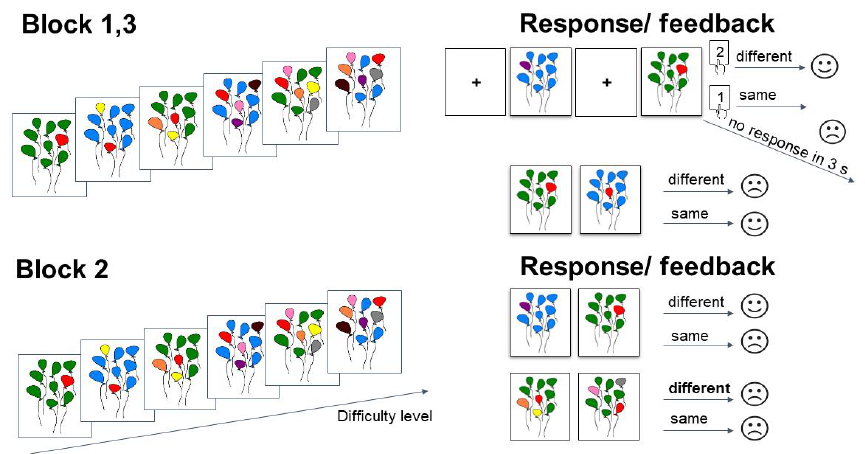
Figure 3. The block scheme of the experimental study. The ‘Different’ point is when colors differed; the ‘Same’ point is when colors did not differ; ‘s’ means seconds. In Blocks 1 and 3, the participants were given correct feedback. In Block 2, the participants were given wrong feedback at the 3rd level in some trials.